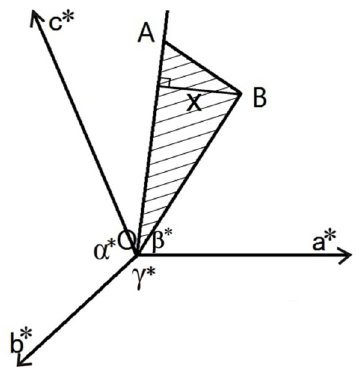
Figure A1. Reciprocal lattice of the triclinic system.